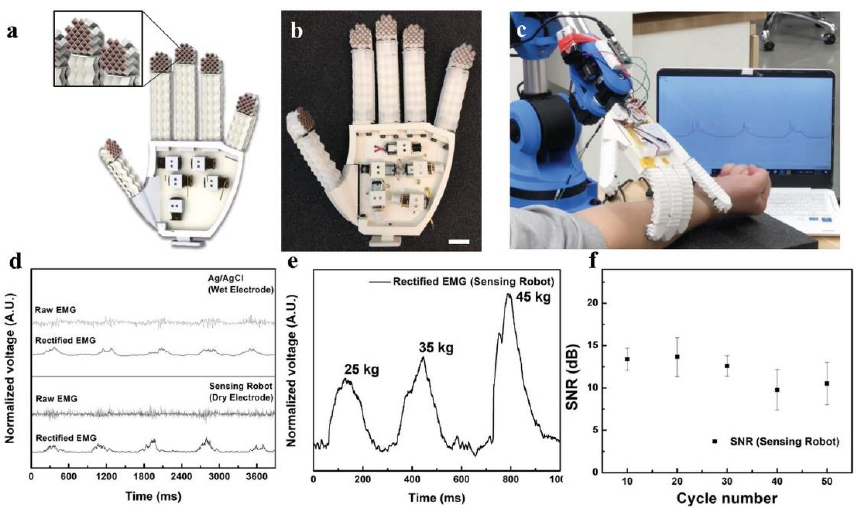
Figure 8. EMG assessment with origami-inspired robotic structures and materials. ( a ) Schematics and ( b ) actual photo image of electromyogram (EMG) sensing humanoid robot hand (scale bar: 2 cm). ( c ) Photo image of the sensing robot during the EMG measurement. ( d ) Typical raw and rectified EMG signals measured by wet Ag/AgCl electrodes ( top ) and the EMG sensing robot ( bottom ). ( e ) Rectified EMG signals at three different fist-holding forces of the participant. ( f ) SNR profiles of EMG sensing robot as a function of touching cycles to the human subject. [T.-H. Kim, J.